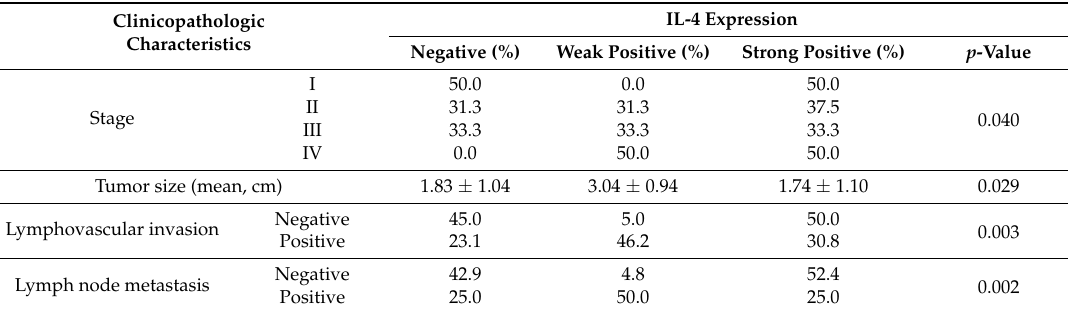
Table 6. Association between interleukin (IL-4) and clinicopathologic characteristics in breast